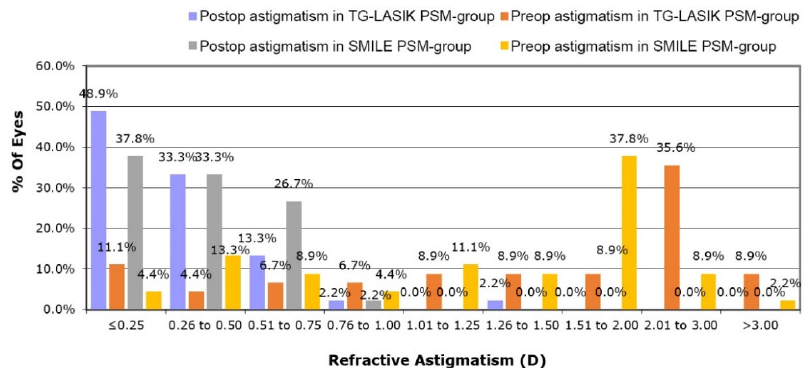
7 of 12 Figure 3. ( A ) Distance visual acuity following TG ‐ LASIK and SMILE. ( B ) Changes in postoperative Snellen lines of CDVA compared with preoperative CDVA in TG ‐ LASIK and SMILE propensity ‐ score ‐ matched groups. (TG ‐ LASIK, topography ‐ guided laser ‐ assisted in situ keratomileusis; SMILE, small incision lenticule extraction; UDVA, uncorrected distance visual acuity; CDVA, cor ‐ rected distance visual acuity). 3.3. Changes in Astigmatism and Corneal Aberration after Surgical Procedures In terms of refractive astigmatism accuracy of each procedure, more eyes in the TG ‐